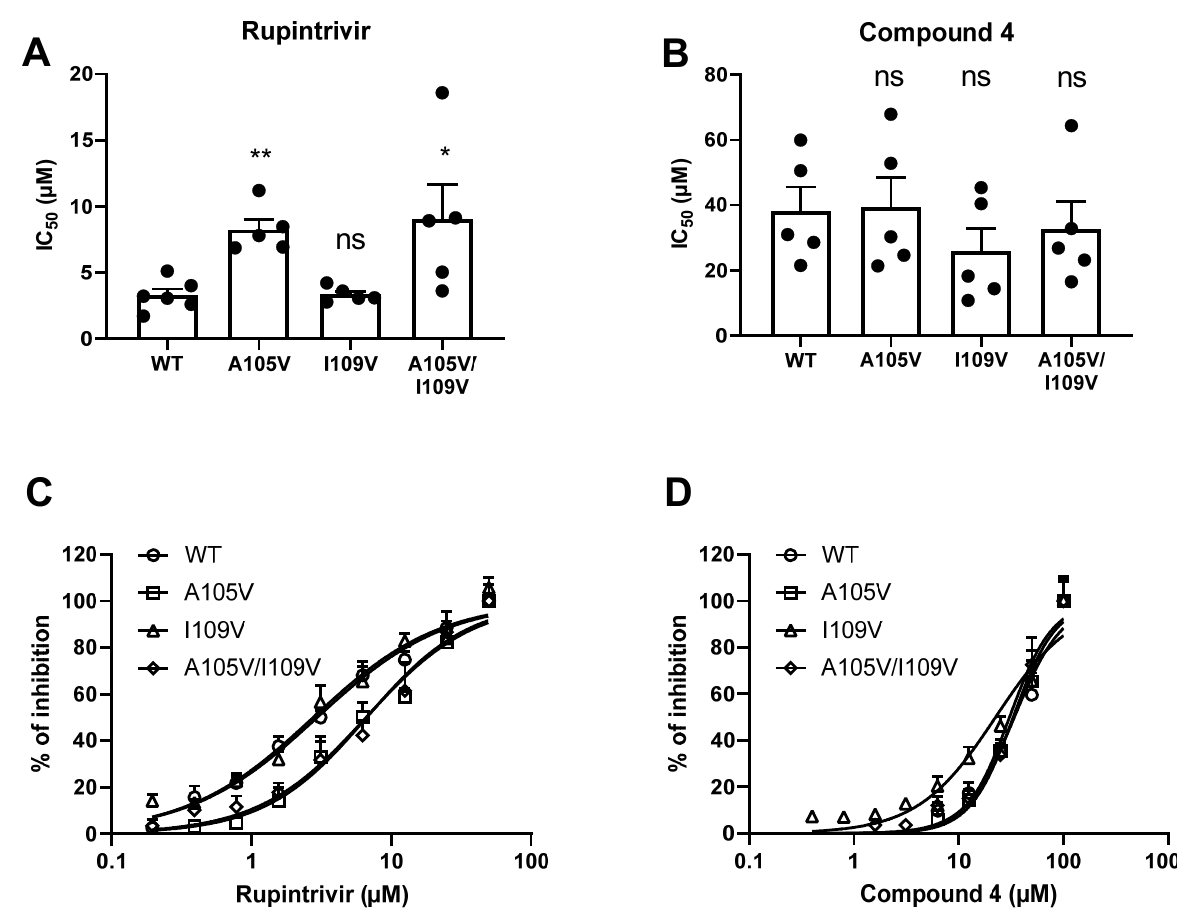
Figure 4. The susceptibility of mutated GI.1 proteases to rupintrivir and compound 4 . IC 50 values of rupintrivir ( A ) and compound 4 ( B ) on the WT or mutant GI proteases. Dose–response inhibition curves of rupintrivir ( C ) and compound 4 ( D ) on the WT or mutant GI proteases. Mean values ± SEM are presented, Mann–Whitney test ** p < 0.01, * p < 0.05, ns: not significant.